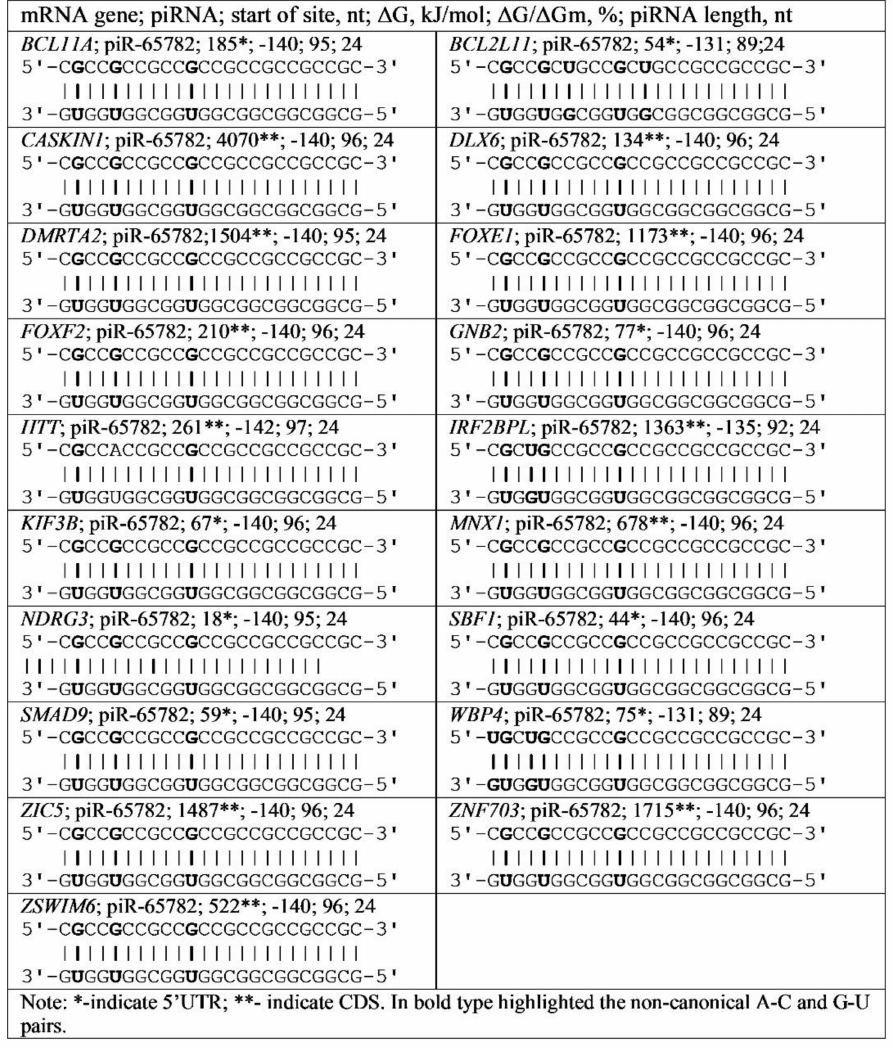
Figure 7. Schemes of piR-65782 interaction with mRNA regions of various genes containing CGC